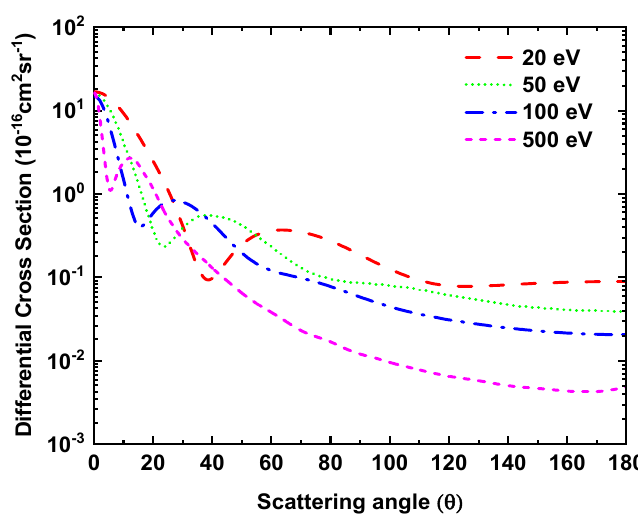
Figure 7. Differential cross sections for positron-H 2 S scattering at incident positron energy 20, 50, 100 and 500 eV.